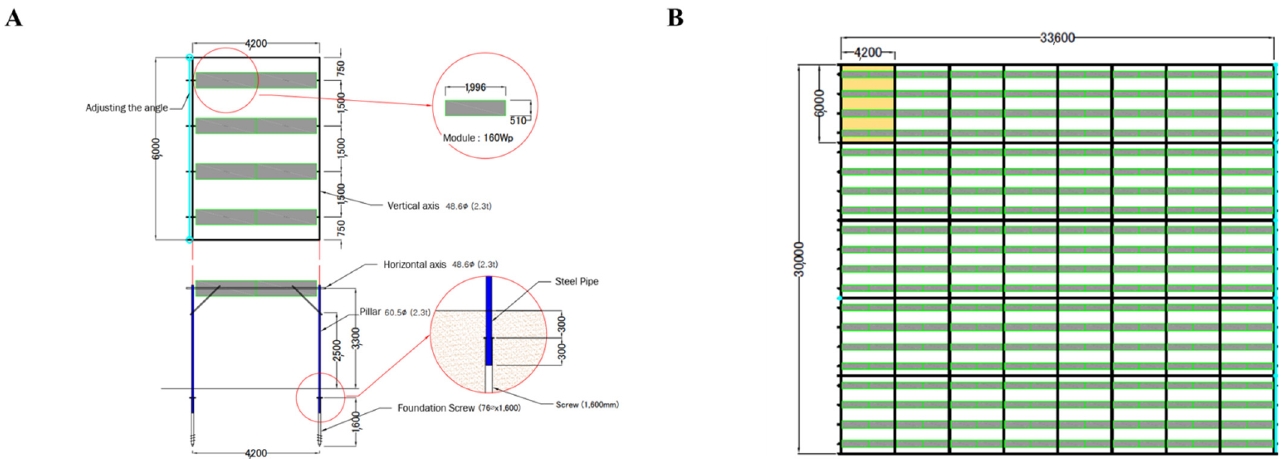
Figure 1. Agro-photovoltaic structure and layout in the experimental paddy field and dry field. ( A ) Structure of the agro-photovoltaic system. ( B ) Layout of the 320 dummy panels in the agro-photovoltaic system.